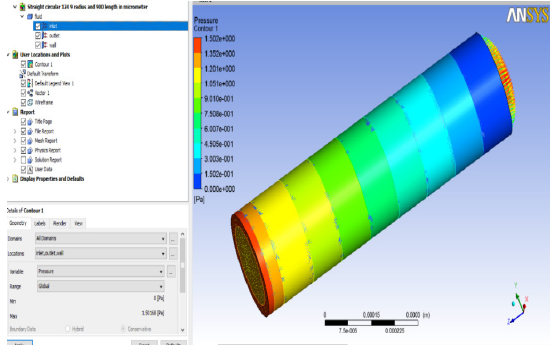
Fig.6: Contour of Pressure for Straight Circular Microchannel With warning error simulation was done for straight circular microchannel at 103.3 aspect ratio. Error free simulation was done for this microchannel at 7.20